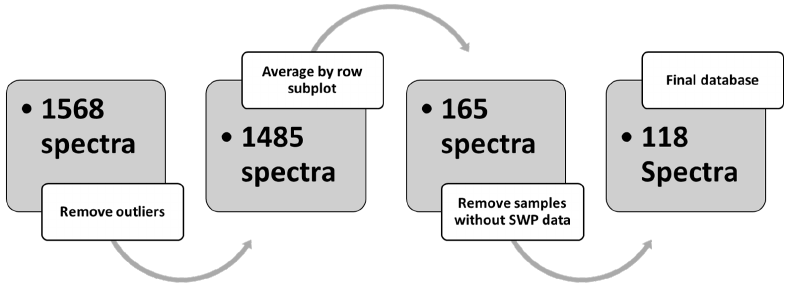
Figure 8. Preprocessing steps, from raw spectra to the database actually used in our study. Outliers were removed according to their reflectance values, especially the ones that had a low reflectance level due to measurement